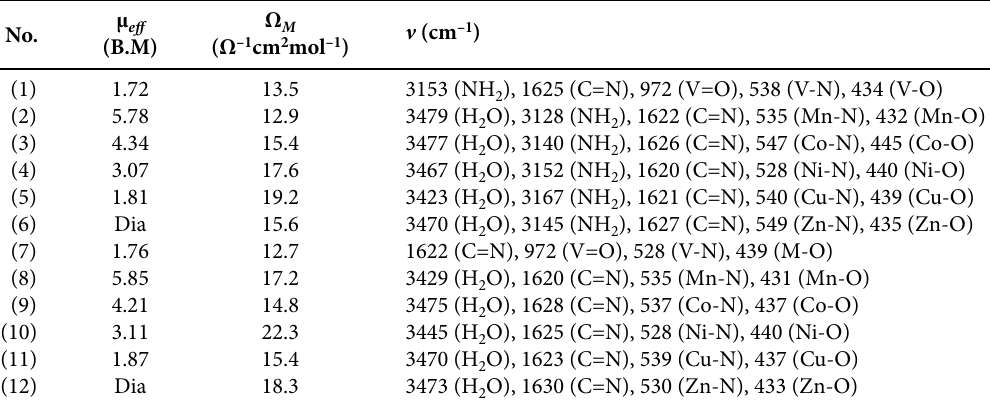
Table 2. Magnetic, conductivity and IR spectral data of metal complexes (1) – (12)